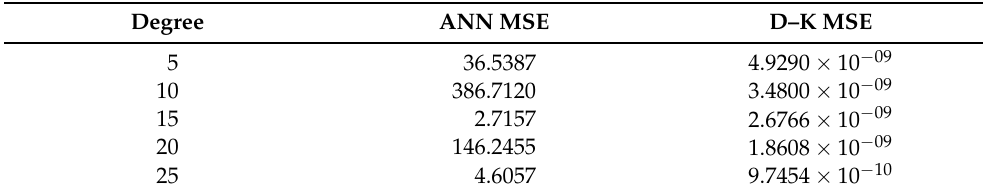
Table 1. Comparison between the ANN approach and the D–K method in terms of MSE for polyno- mials with real and complex